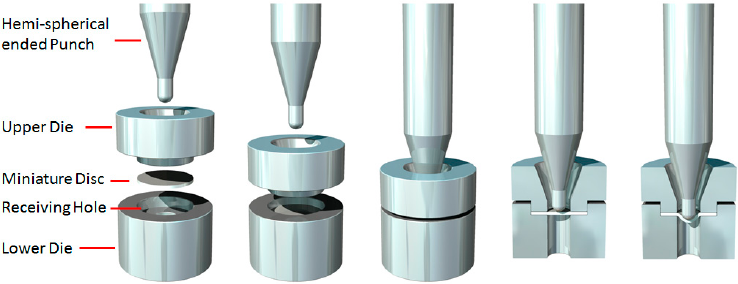
Figure 2. Schematic representation of the small punch (SP) test method.